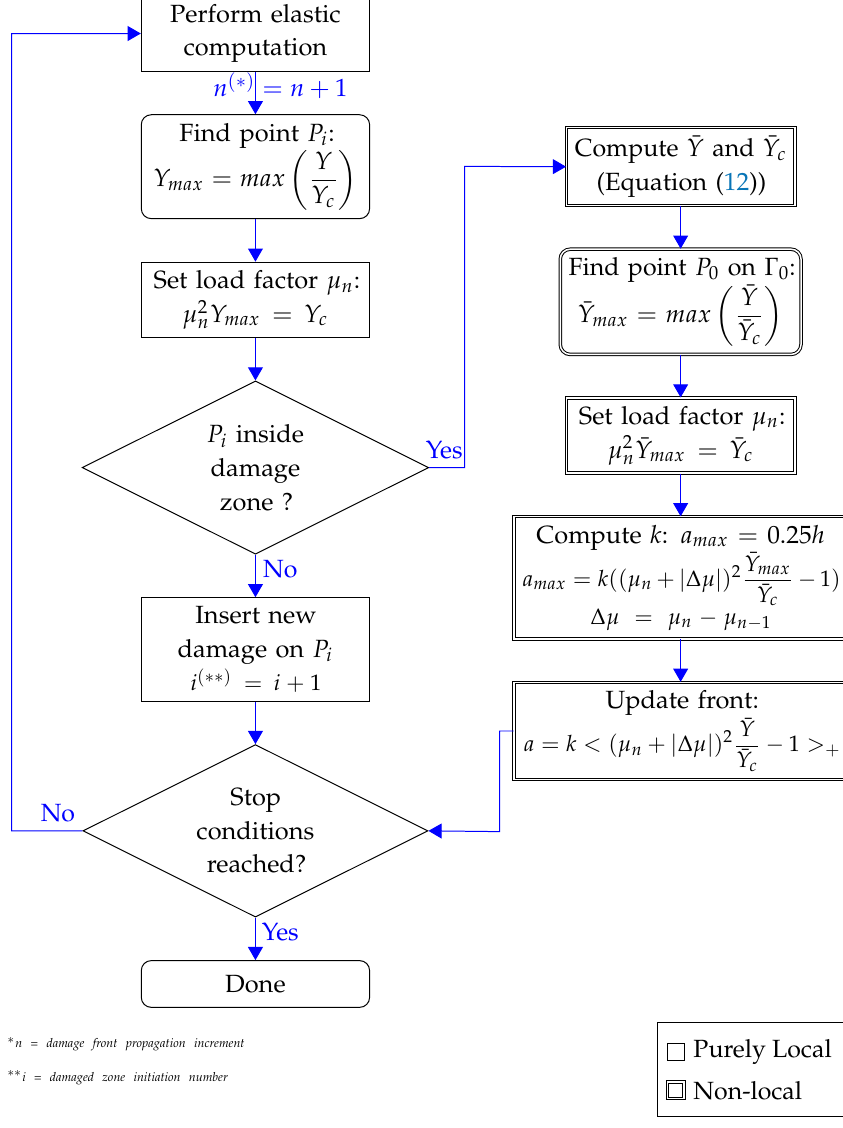
Figure 2. Flowchart of the incremental computation of damage initiation and